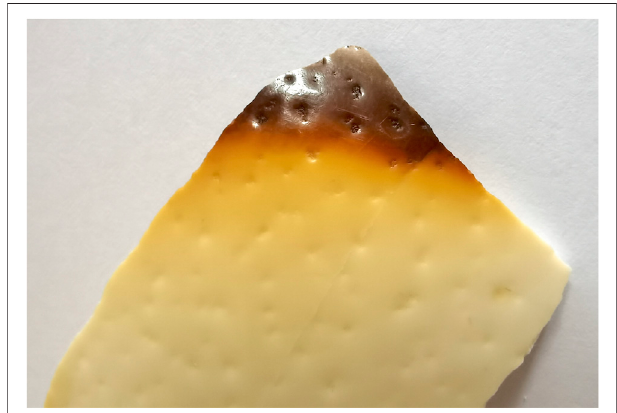
FIGURE 8 | OES boiling experiment. The image shows a piece of OES that had been partially suspended in boiling water. The color change of the submerged part (top), followed by the color transition at the water line, can be